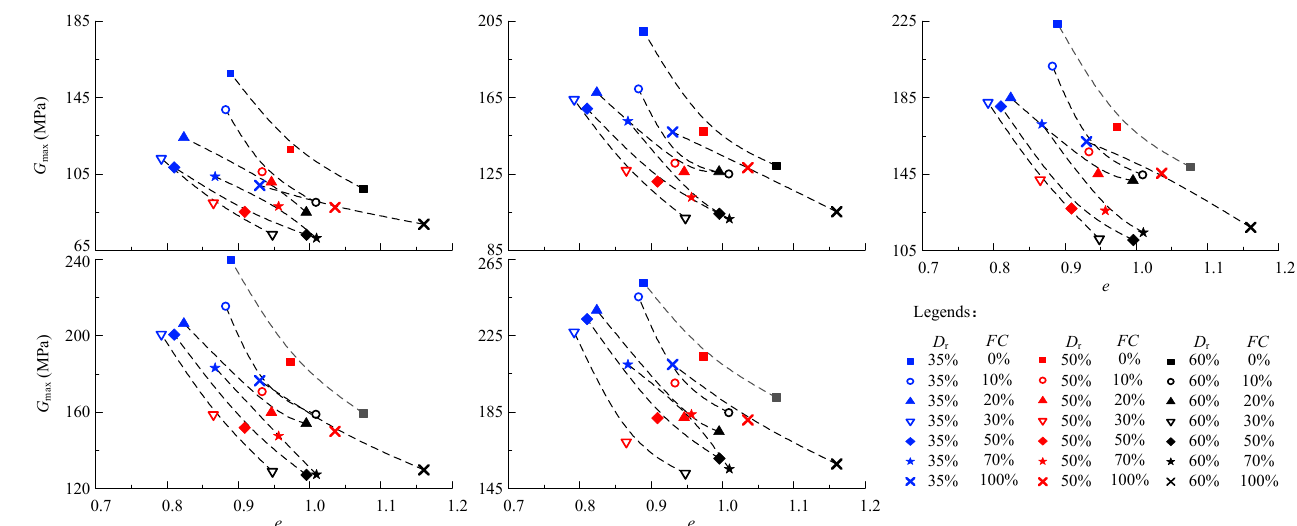
σ′ Figure 6. The relationship between the G max and . The relationship between the G max and e of the samples were illustrated in Figure 7. σ′ and FC , the G max decreased with the increasing e . The For the samples under a given 3c decreasing rate of the G max with respect to e was distinctly influenced by FC when the σ′ was the same. Yang et al. [21] found that the relationship between the G max and e of 3c σ′ was linear, and the decreased rate of the G max with the samples under various FC or 3c respect to e was unrelated to FC . The different conclusions mean that the correlation between the G max and e is related to the material type of the mixed soils, which needs Figure 7. The relationship between the G max and e Figure 7. The relationship between the G max and e . further study to find the influence factors.